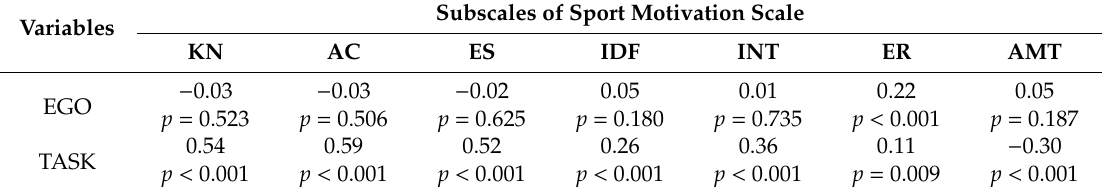
Correlations of ego subscale and task subscale with Sport Motivation Scale